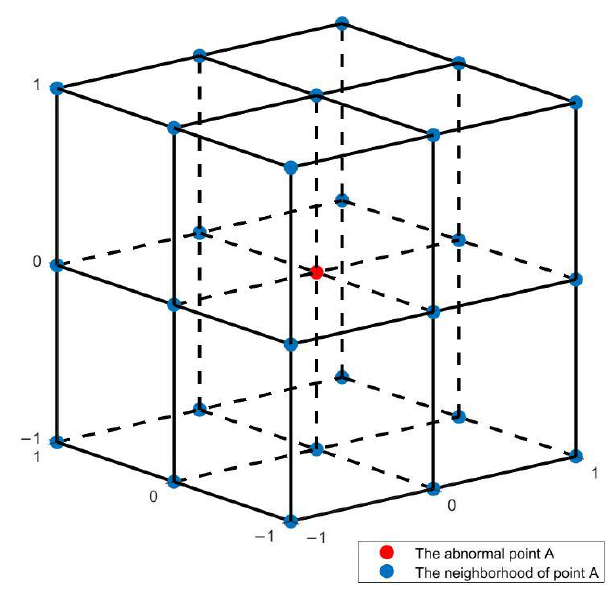
Figure 6. The schematic diagram of the neighborhood region.